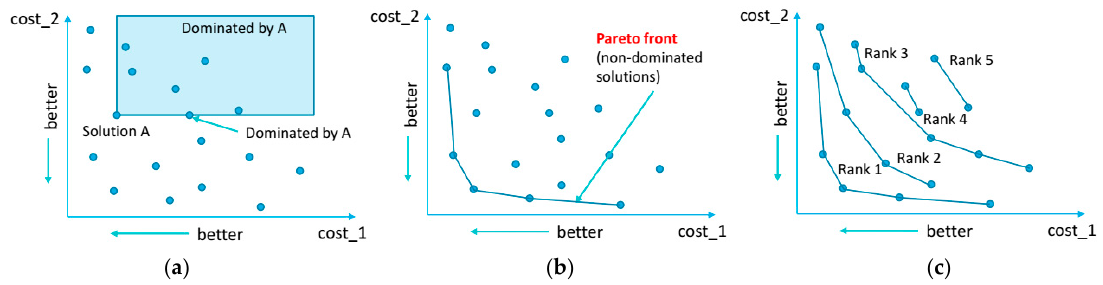
Figure 8. Multi-objective optimization: definitions of dominance criterion ( a ), Pareto front ( b ), and ranking of Pareto fronts ( c ) [31].